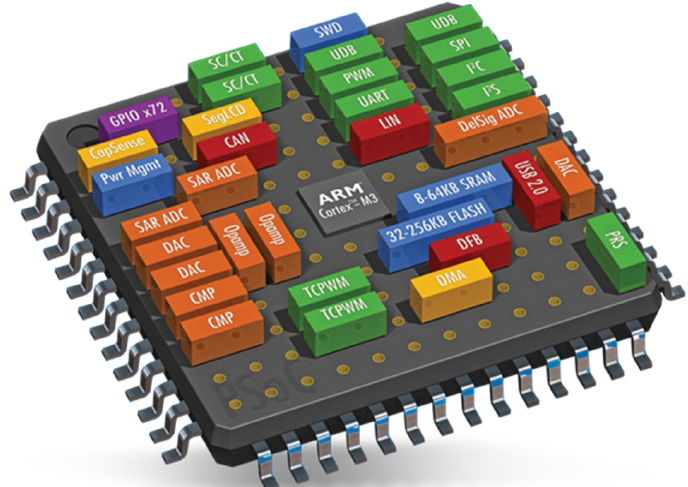
Figure 1. PSoC ® 5LP ARM ® Cortex™ Low-power, ARM ® Cortex-M3-based programmable system from Infineon Technologies. Source: https://www.mouser.co.uk/new/cypress-semiconductor/cypress-psoc-5lp-socs/ (accessed date: 8 March 2022).